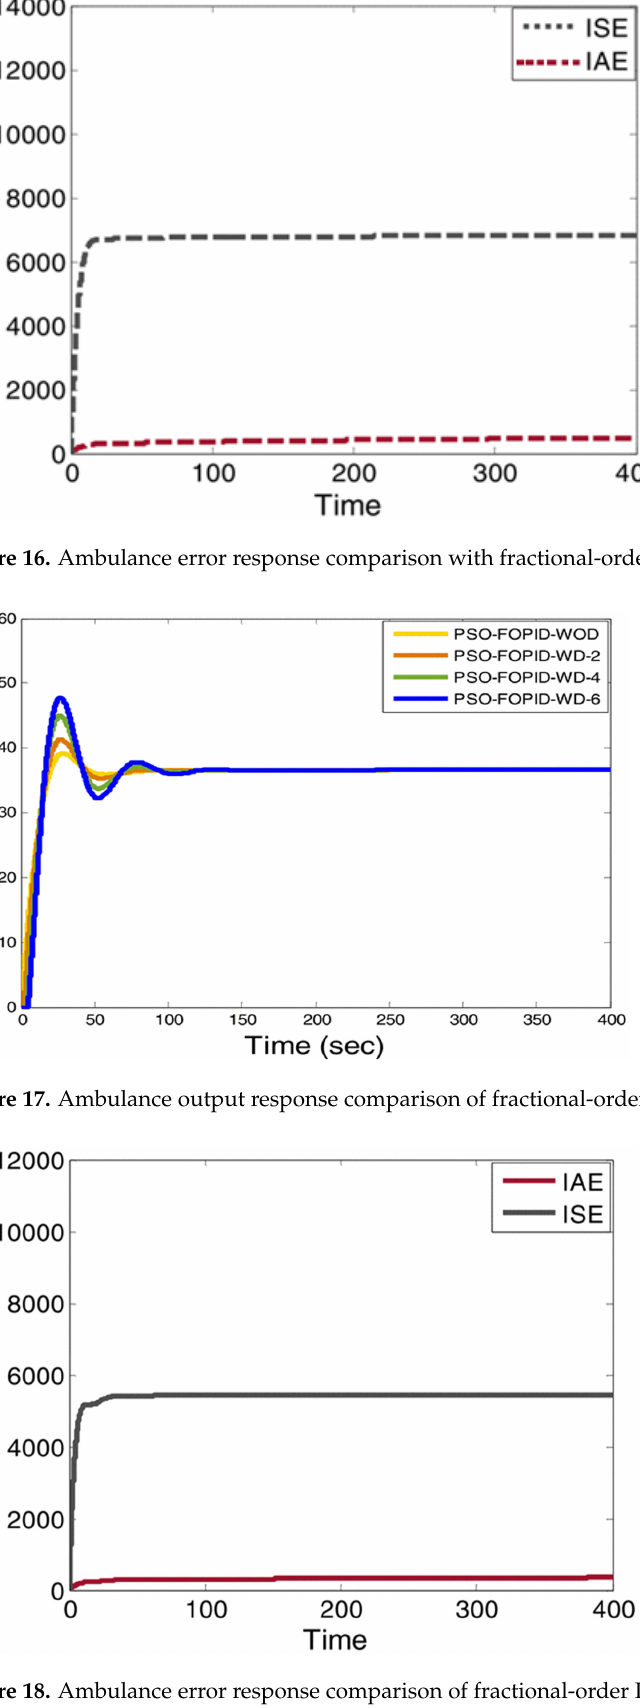
Figure 18. Ambulance error response comparison of fractional-order PID, along with PSO.